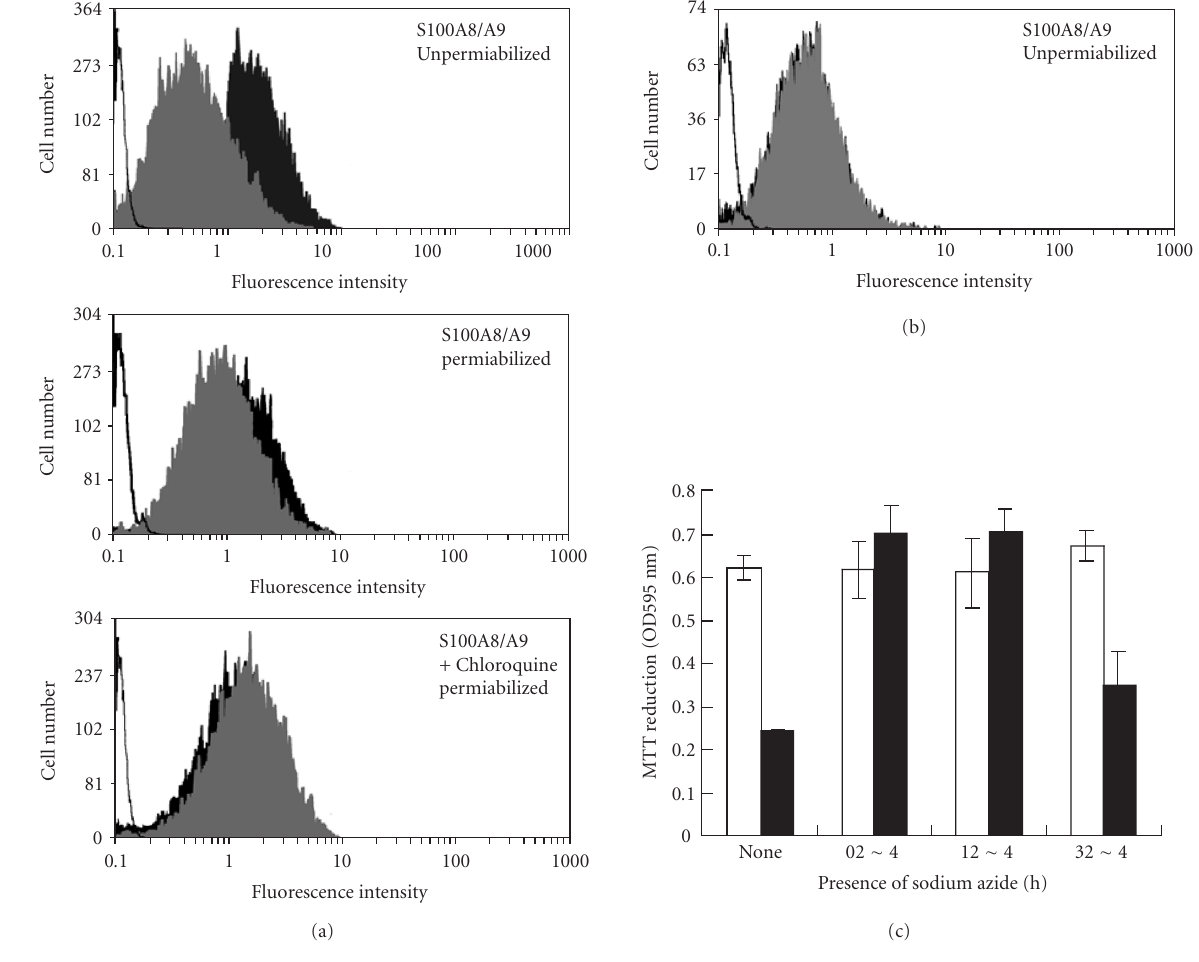
Figure 6. Detection of intracellular S100A8/A9 complex in MM46 cells. (a) MM46 cells were treated at 37 ◦ C without (black line), or with 10 µ M S100A8/A9 for 1h (black histogram) or 3h (gray histogram). In the upper panel, the treated cells were washed and S100A8/A9 binding was immediately analyzed with anti-S100A9 antibody. In the middle panel, the treated cells were washed, fixed, and permeabilized with saponin, and the cell-associated S100A8/A9 was detected with anti-S100A9 antibody. In the lower panel, the cells were incubated with S100A8/A9 in the presence of 100 µ M chloroquine, and after that, the cells were washed, fixed, and permeabilized with saponin, and the cell-associated S100A8/A9 was detected with anti-S100A9 antibody. (b) E ff ects of sodium azide on the changes in the binding profile of S100A8/A9. The cells were incubated at 37 ◦ C without (black line) or with S100A8/A9 plus 50 mM sodium azide for 1 h (black histogram) or 3h (gray histogram). After that, the cells were washed and S100A8/A9 binding was immediately analyzed with anti-S100A9 antibody. (c) E ff ect of sodium azide on the apoptosis-inducing activity of S100A8/A9. MM46 cells were cultured with (filled column) or without (open column) 10 µ M S100A8/A9 for 24h. Sodium azide (50mM) was present in the culture during the indicated periods. Bars represent